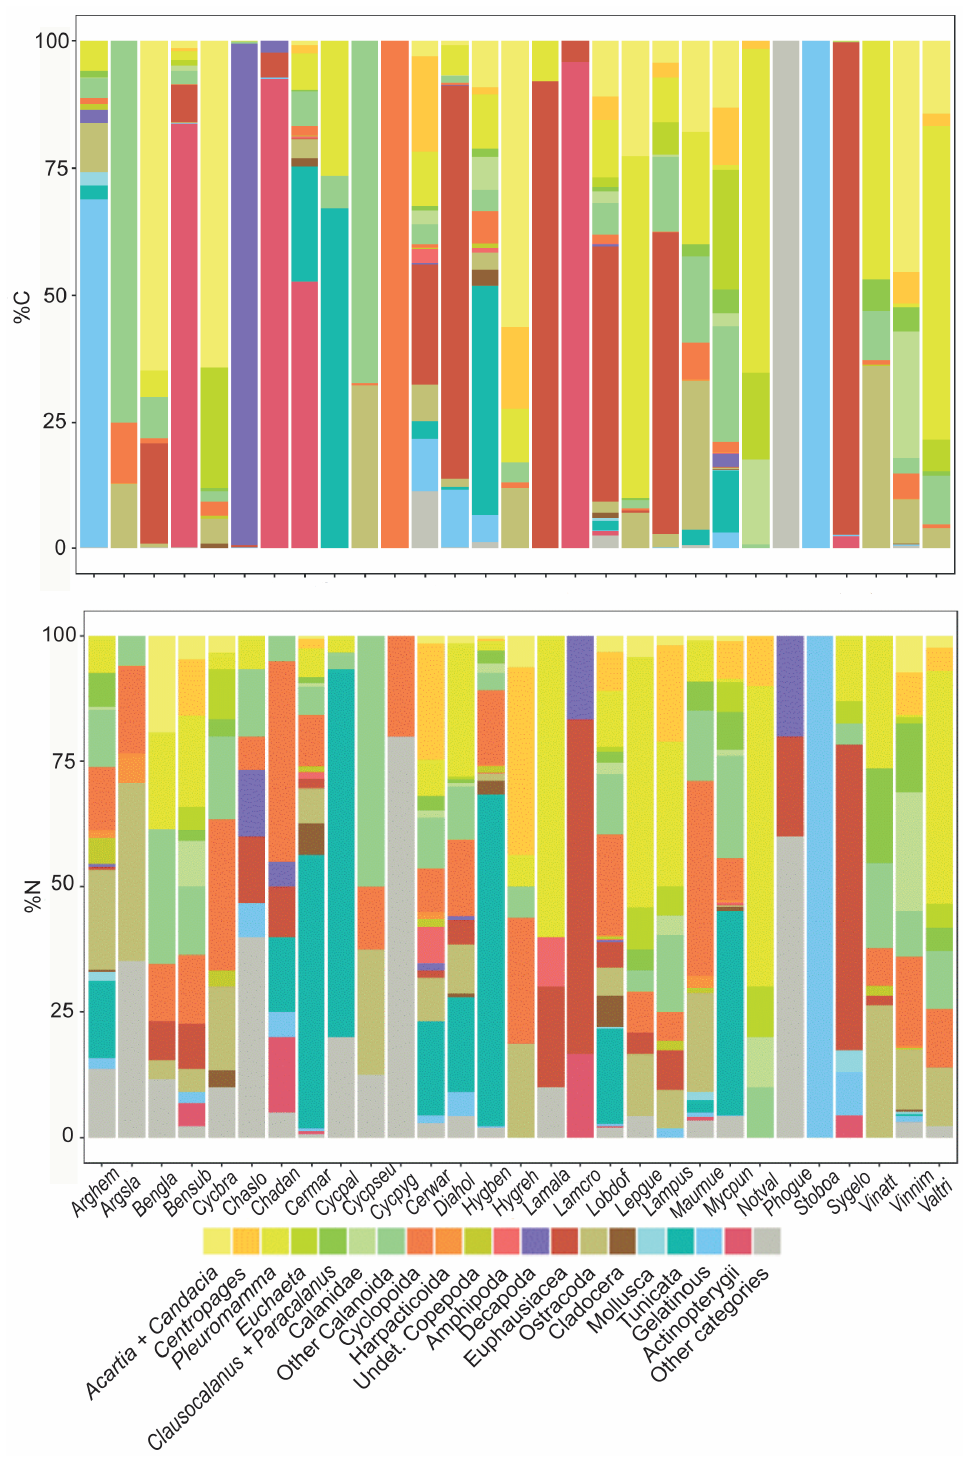
Figure 6. Diet compositions of Myctophiformes and Stomiiformes, pooling individuals of the five zones studied by fish species and expressed as a percentage of carbon content (%C) and percentage of abundance (%N). Prey taxa were reduced to 20 categories; “Other categories” represents <1% N. The names of the fish species are abbreviated as the first three letters of each word of the binomial scientific name.